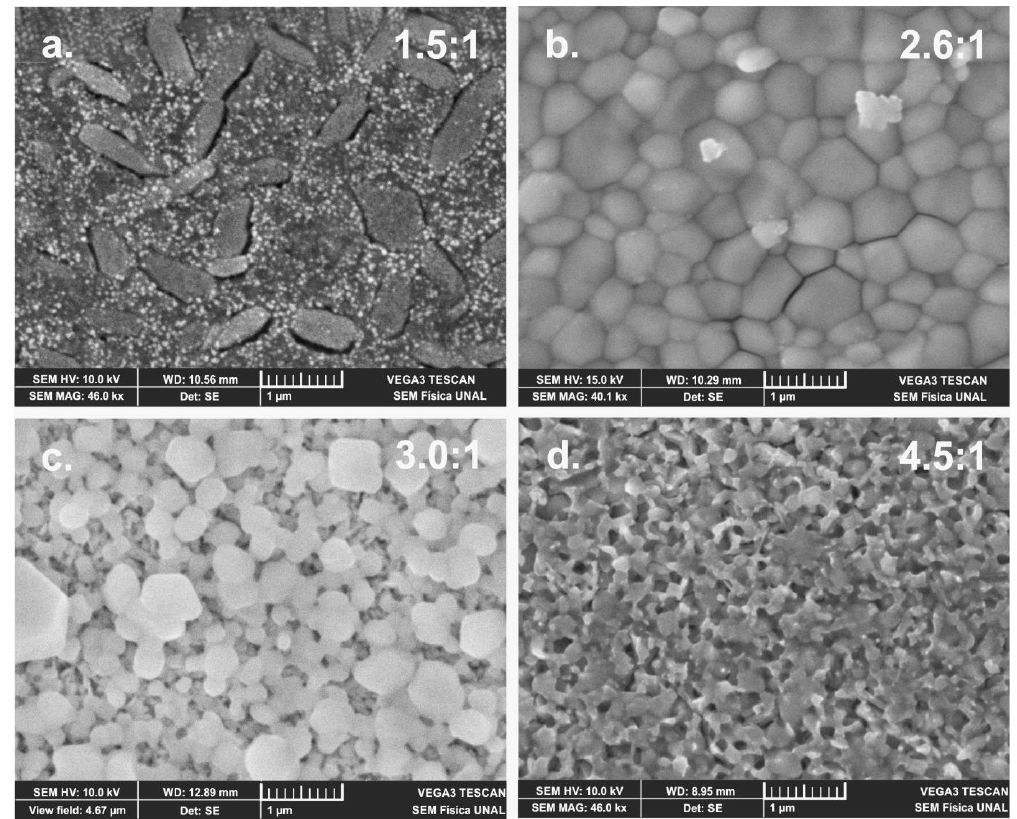
Figure 10. SEM images of MAPI films prepared at room temperature and PbI 2 / MAI thickness ratio of ( a ) 1.5: 1, ( b ) 2.6: 1, ( c ) 3.0: 1 and ( d ) 4.5: 1.